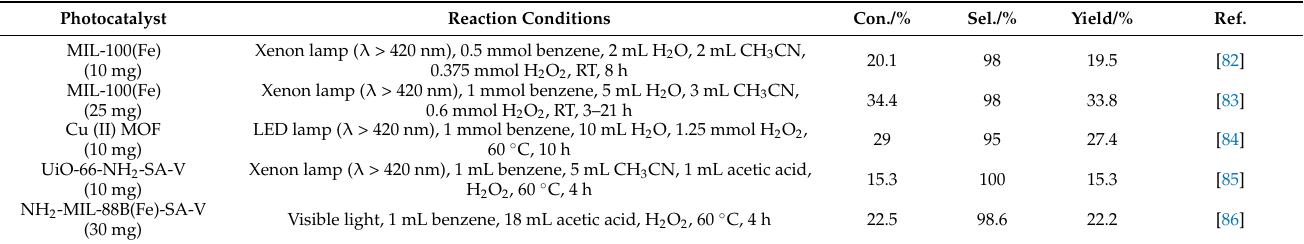
Table 4. Catalytic performance of MOFs-based photocatalysts for benzene hydroxylation. Photocatalyst Reaction Conditions Con./% Sel./% Yield/%